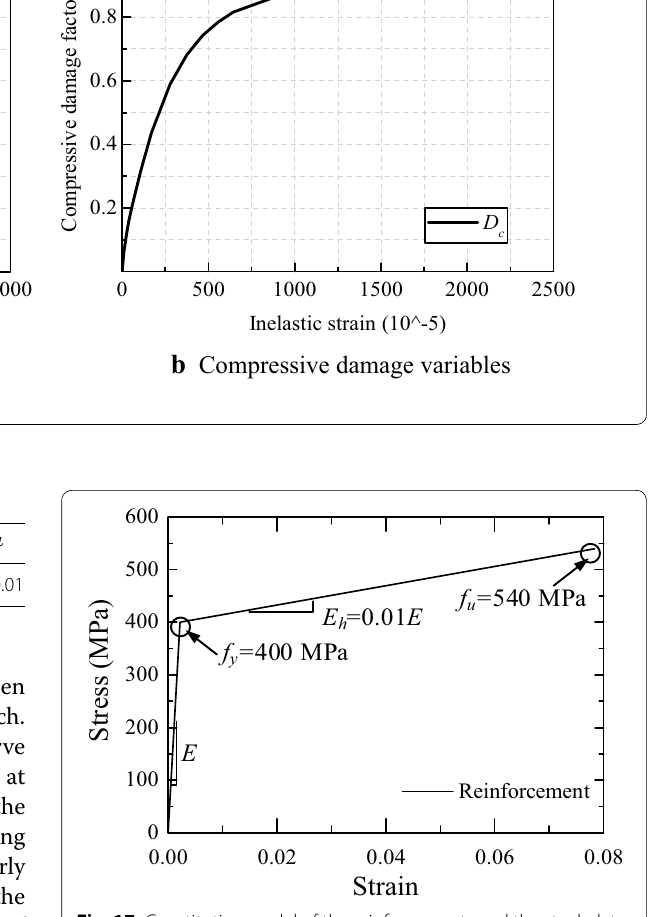
Fig. 17 Constitutive model of the reinforcements and the steel